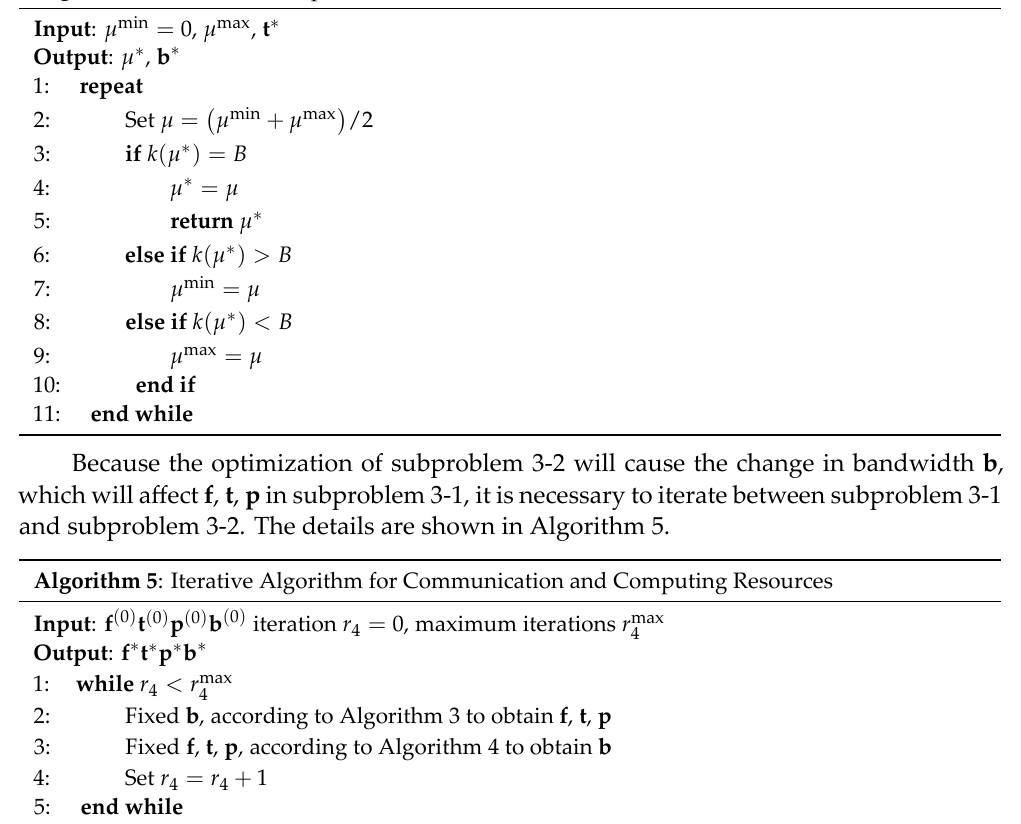
Algorithm 4 : Solve The Subproblem 3‑2: b